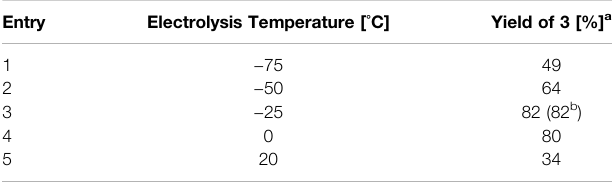
TABLE 2 | Optimization of electrolysis temperature in the batch reactor.